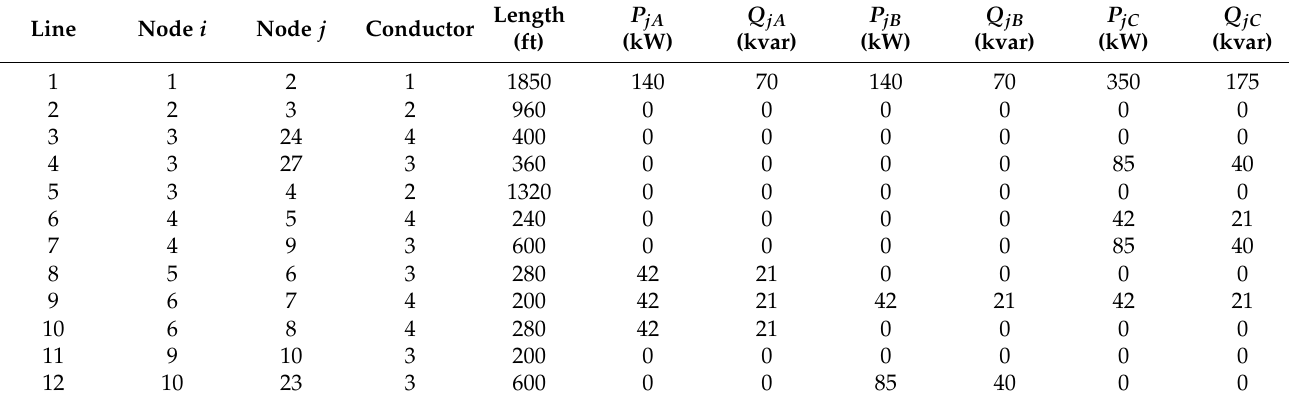
Table A5. Loads and lines parameters of the IEEE 37-node test